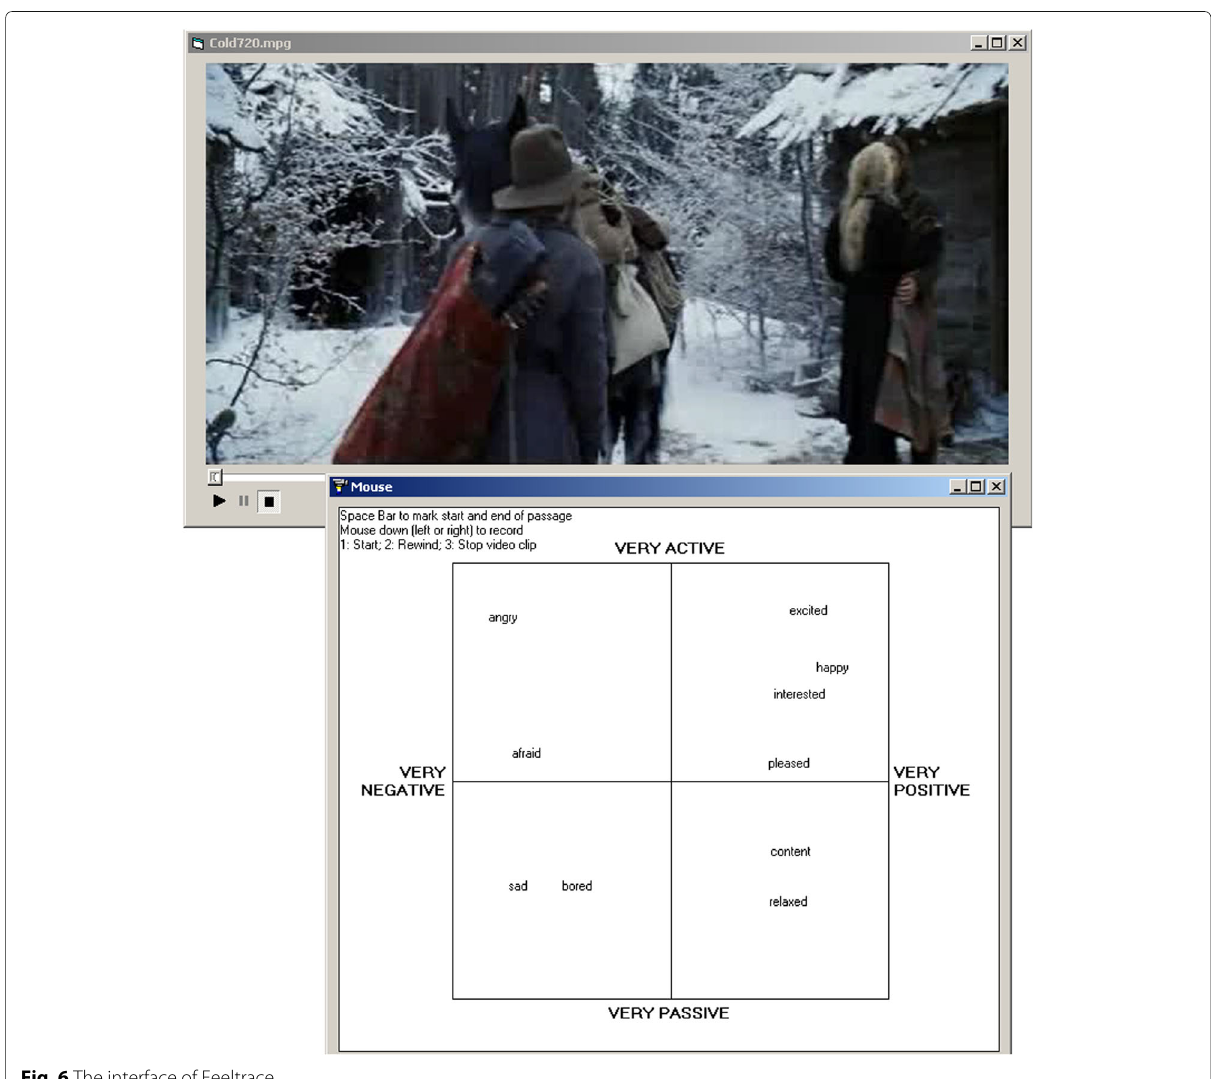
Fig. 6 The interface of Feeltrace